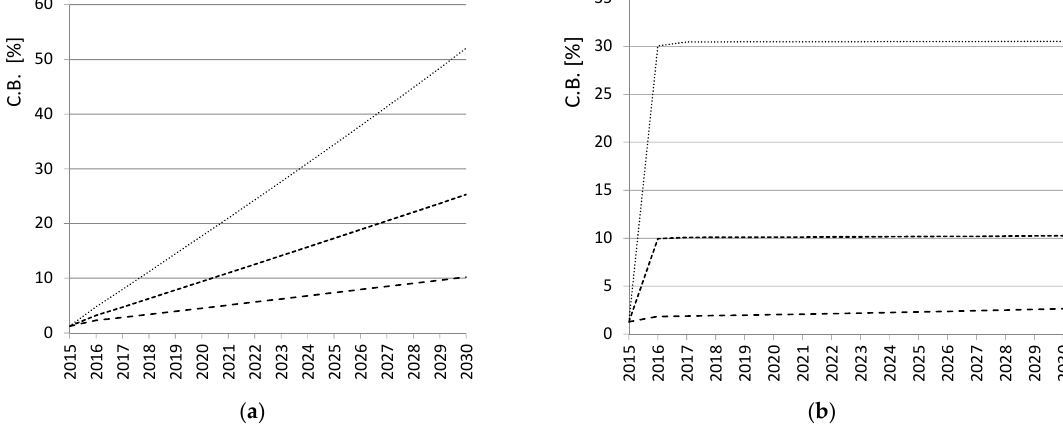
Figure 3. Average 95% confidence intervals as a percentage of the C res value. ( a ) Linear increase of the std. dev. associated to the exogenous variables, three different rates; ( b ) Constant std. dev. during the whole time horizon, three different levels. See Figure 2. Table 5. Model parameters found from data of Table 1.